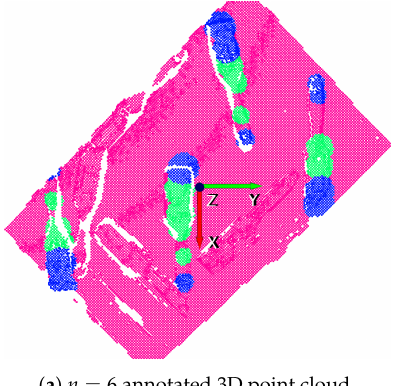
Figure 8. Annotation transformation for gripper.